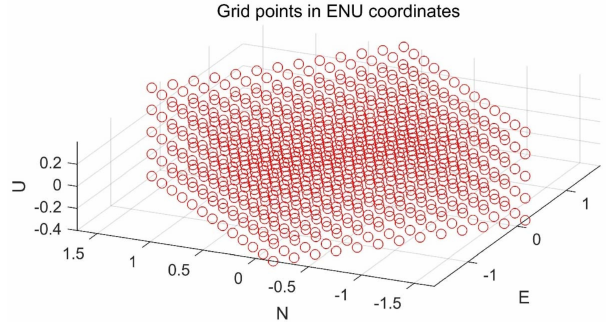
Figure 5. A typical example for the grid creation